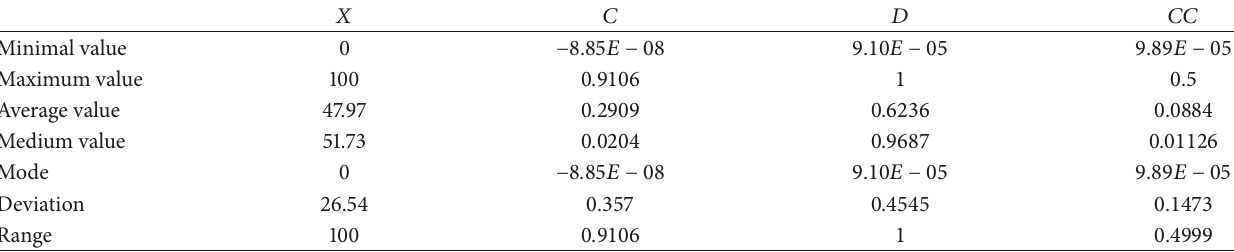
Table 6: The statistical analyses of strategies 𝐶 , 𝐷 , and 𝐶𝐶 .